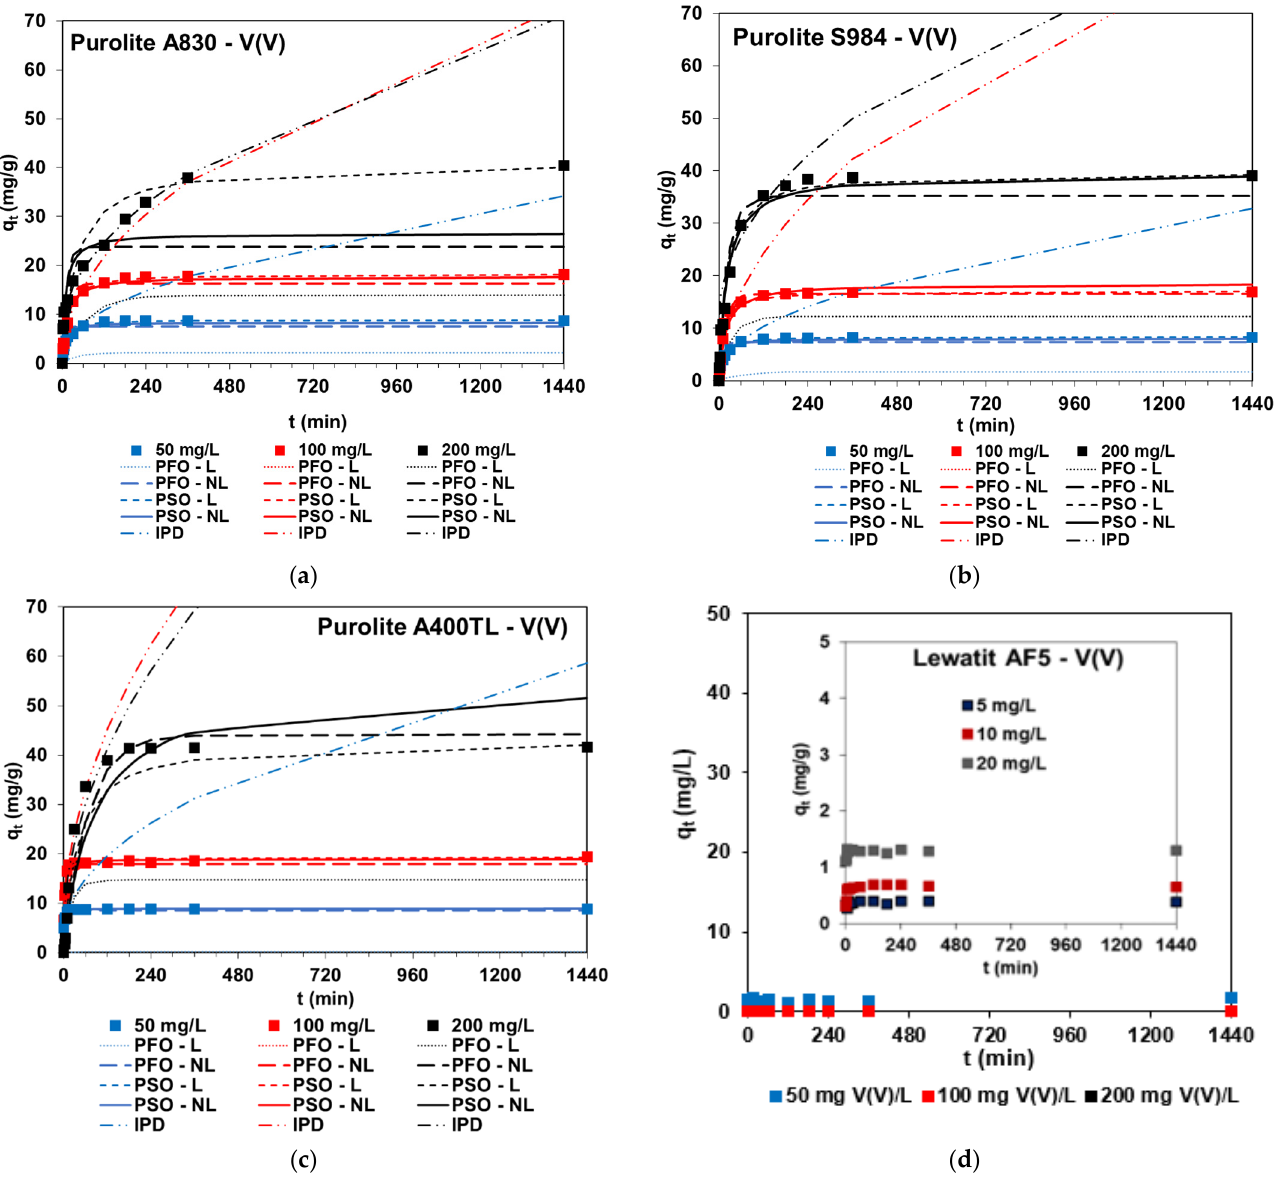
Figure 8. Effects of phase contact time and initial concentration on the amount of vanadium adsorbed on ( a ) A830, ( b ) S984, ( c ) A400TL, and ( d ) AF5.